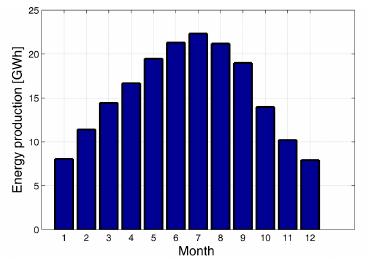
Figure 9. Monthly production of the FPPP.